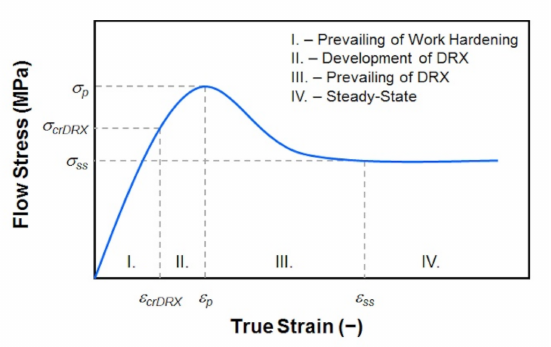
Figure 1. The schematic representation of flow stress curve influenced by dynamic recrystalliza- tion